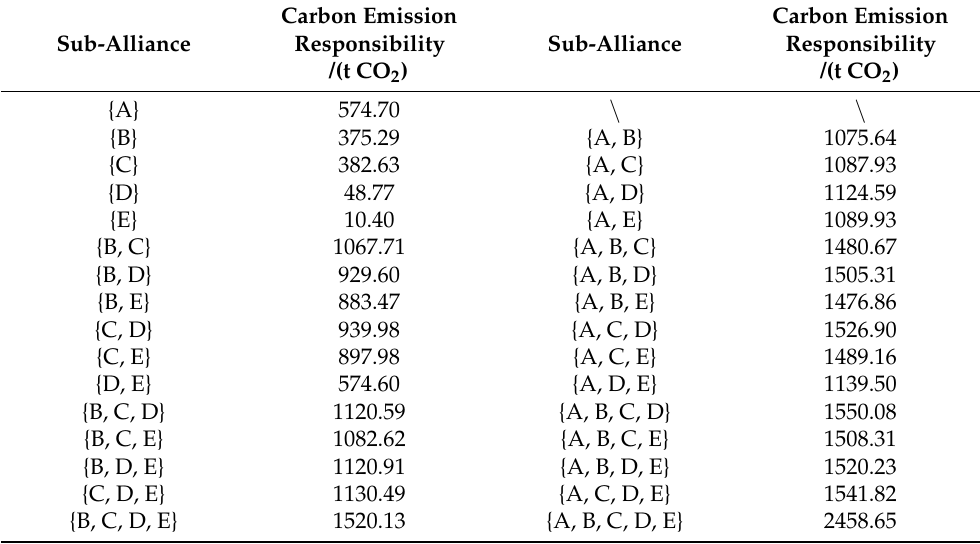
Table 5. The carbon emission responsibility of each